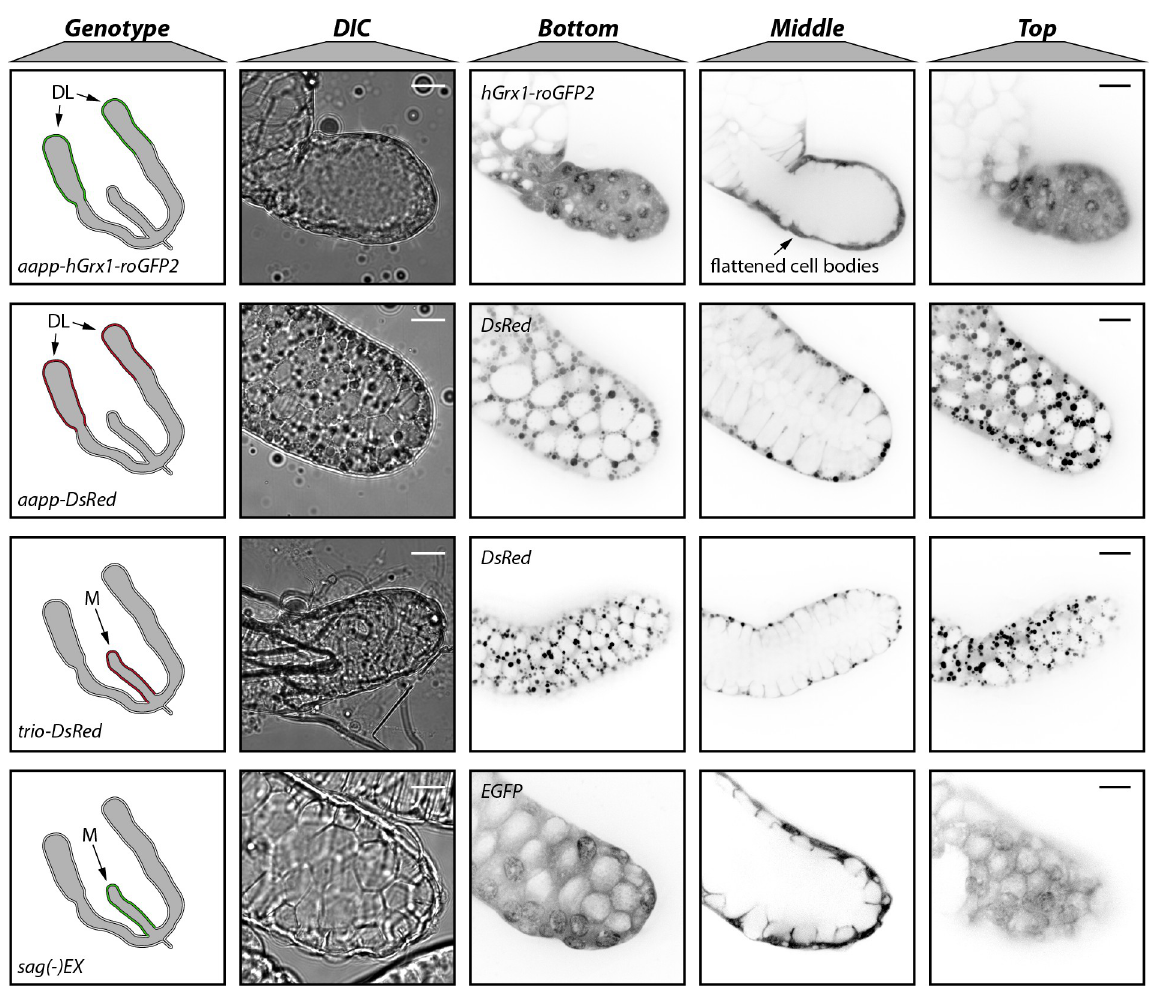
Fig 4. Different subcellular localizations of DsRed, EGFP and hGrx1-roGFP2 fluorescent reporters. Differential interference contrast (DIC) and confocal fluorescence images of the distal-lateral lobes ( aapp-DsRed , trio-DsRed ) or the median ( trio-DsRed , sag(-)EX ) salivary gland lobes. Different z-sections (top, middle and bottom) of the same glands are displayed in the relevant fluorescence channel. Cell bodies of acinar cells in the tips of distal lobes expressing high levels of hGrx1-roGFP2 appeared flattened (as indicated) compared to cells expressing aapp-DsRed . Note that DIC and fluorescence images were taken with a Hamamatsu Orca Flash 4.0 V1 and a Yokogawa CSU X-1 camera, respectively. Images between different channels are therefore not completely matching although depicting the same salivary gland. Illustrations on the left depict the genotype of the lines and corresponding expression patterns. All images were acquired in the same microscopy session. Scale bars: 20 μ m.